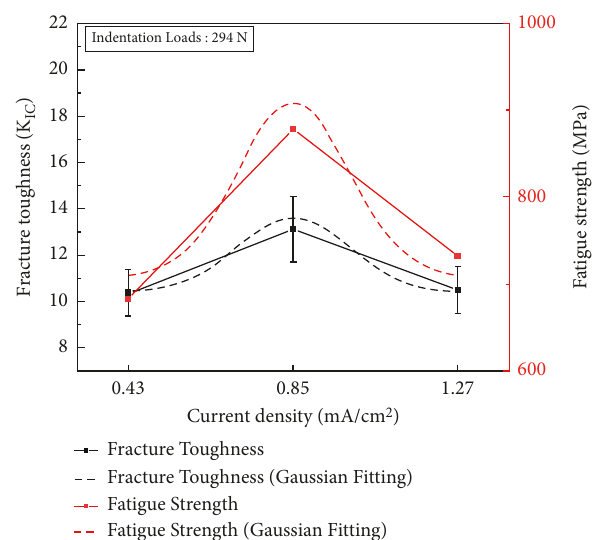
Figure 8: Relation between the fatigue strength and the fracture toughness for the ion-nitrided specimens.